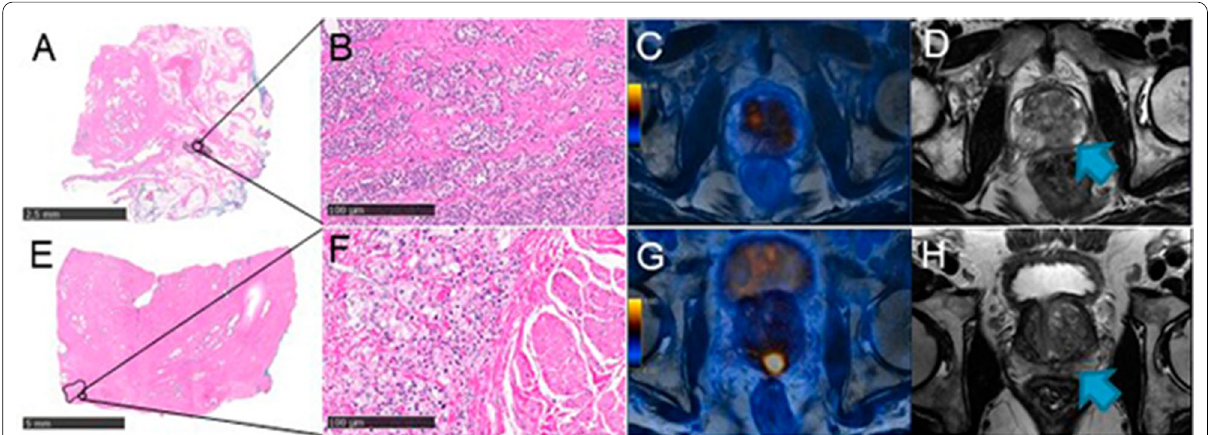
Fig. 5 [ 68 Ga]PSMA-PET/MRI and mpMRI images of a 66-year-old patient with PSA of 6.1 ng/ml that subsequently underwent radical prostatectomy (ISUP 4). a , b Histopathology slide positive for EPD with a overview (bar 2.5 mm) and b magnification (bar 100 µm), showing PCa on = = the posterior left part of the prostate with EPD of 6.5 mm; c corresponding axial [ 68 Ga]PSMA PET/MRI with SUV max of 4.8, PSMA tot of 9.3 g/ ml, and PSMA vol of 2.1cm3; d axial T2-weighted mpMRI showing an LCC of 28 mm (blue arrow). e – h 69-year-old patient with PSA of 5.8 ng/ ml that subsequently underwent radical prostatectomy (ISUP 5). e – f Histopathology slide positive for EPD with e overview (bar 5 mm) and f = magnification (bar 100 µm) showing PCa on the posterior mid-gland prostate with a small EPD of 1.5 mm; g corresponding axial [ 68 Ga]PSMA PET/ = MRI with SUV max of 11.8, PSMA tot of 36.1 g/ml, and PSMA vol of 6.35cm3; h axial T2-weighted mpMRI showing an LCC of 11 mm (blue arrow)